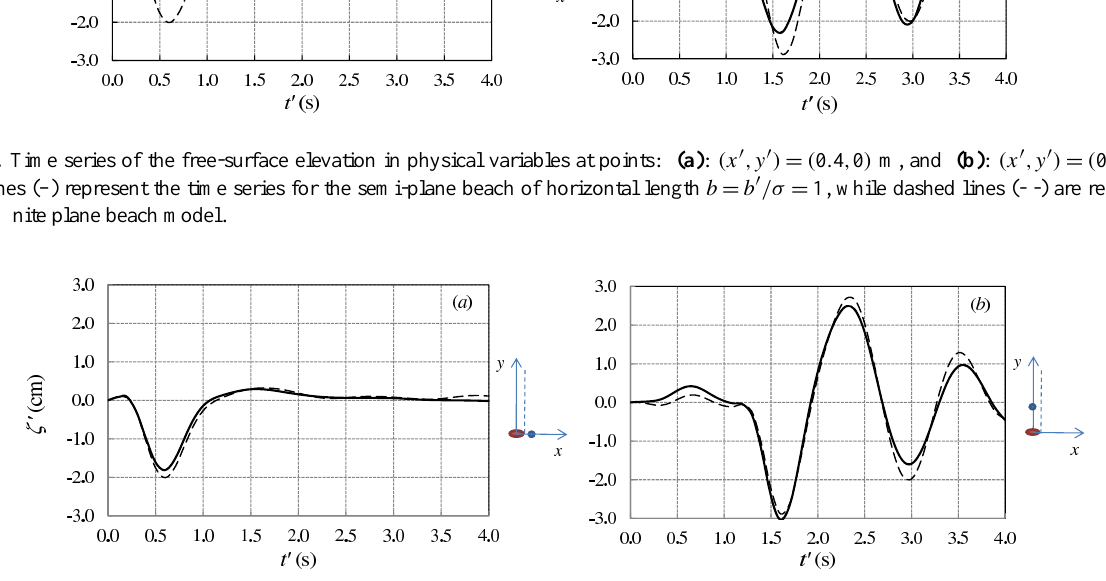
Fig. 13. Time series of the free-surface elevation in physical variables at points: (a) : (x 0 ,y 0 ) = ( 0 . 4 , 0 ) m and (b) : (x 0 ,y 0 ) = ( 0 , 0 . 8 ) m. Solid lines ( – ) represent the time series for the semi-plane beach of horizontal length b = 10, while dashed lines (- -) are relevant to the indefinite plane-beach model. Note that for b (cid:29) 1 the two models converge to the same